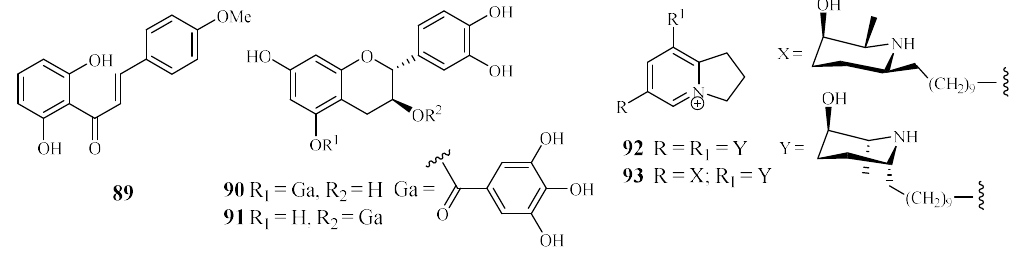
Figure 17. Compounds from Fabaceae plants.